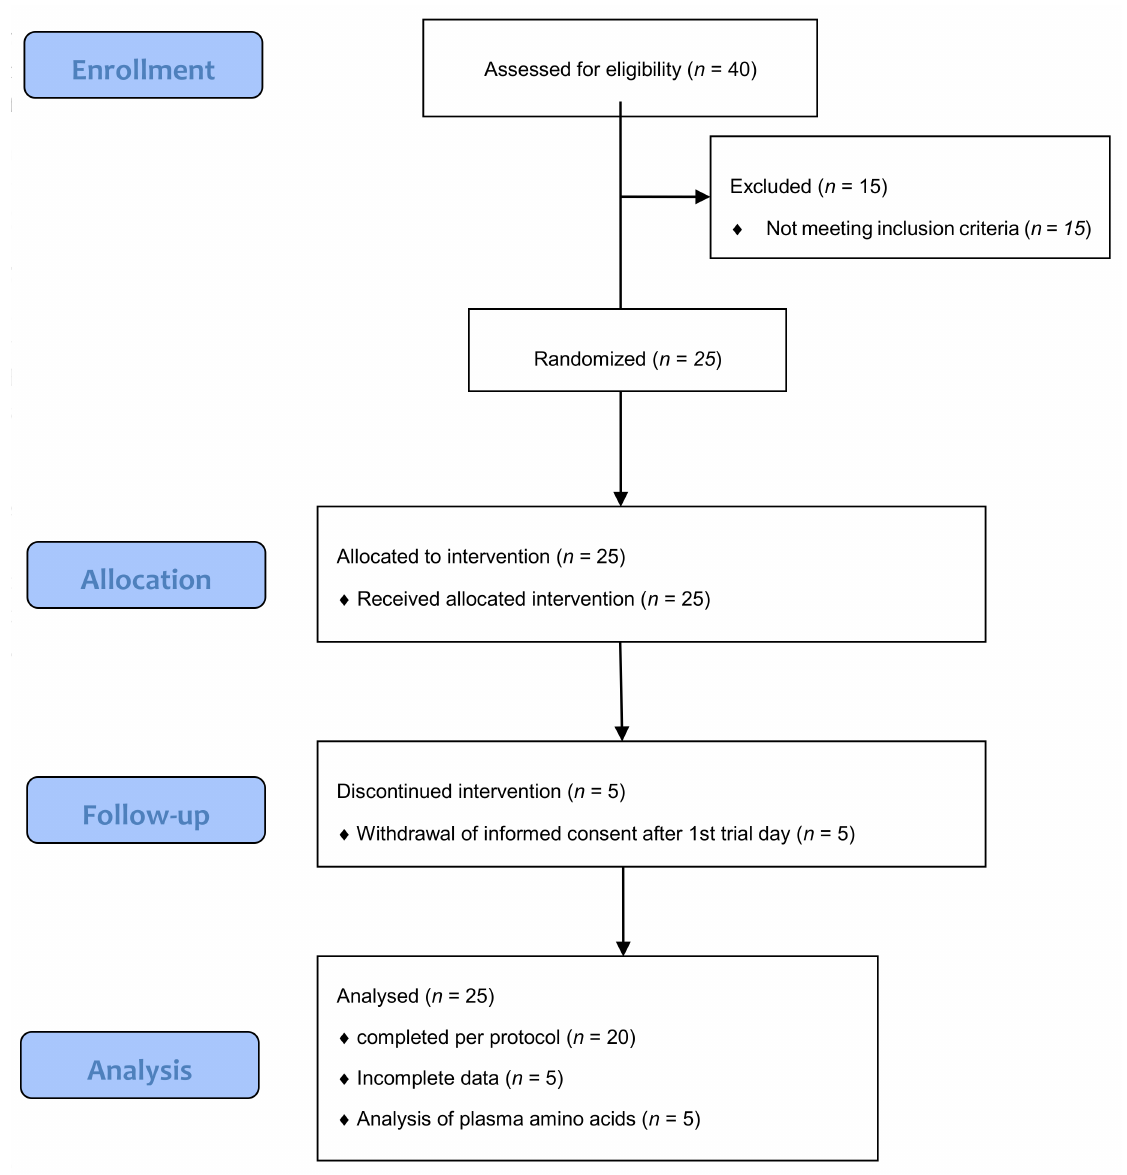
Figure 1. Participant